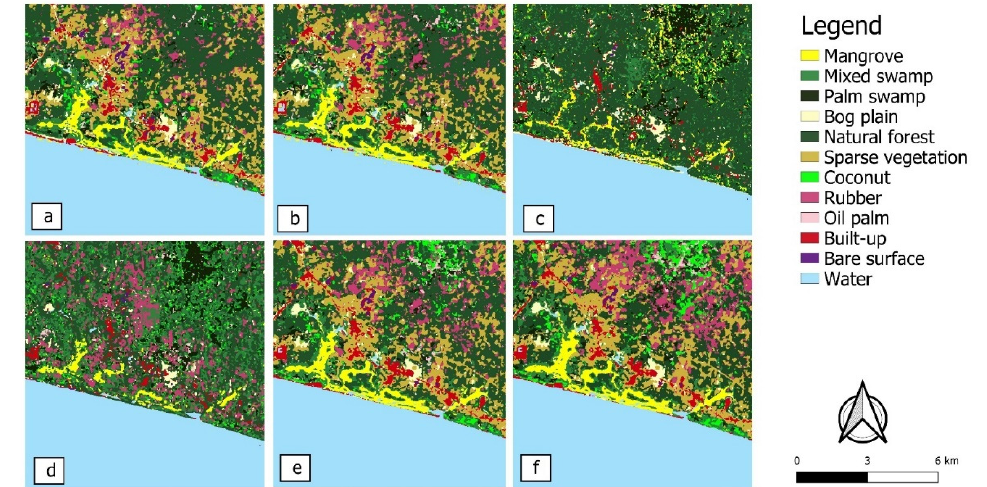
Figure 5. Land cover classification results of a small part of the study area (zoomed in for ease of viewing) using the ( a ) S2, ( b ) S2+, ( c ) S1, ( d ) S1+, ( e ) S2+S1+ and ( f ) S2+S1+DEM